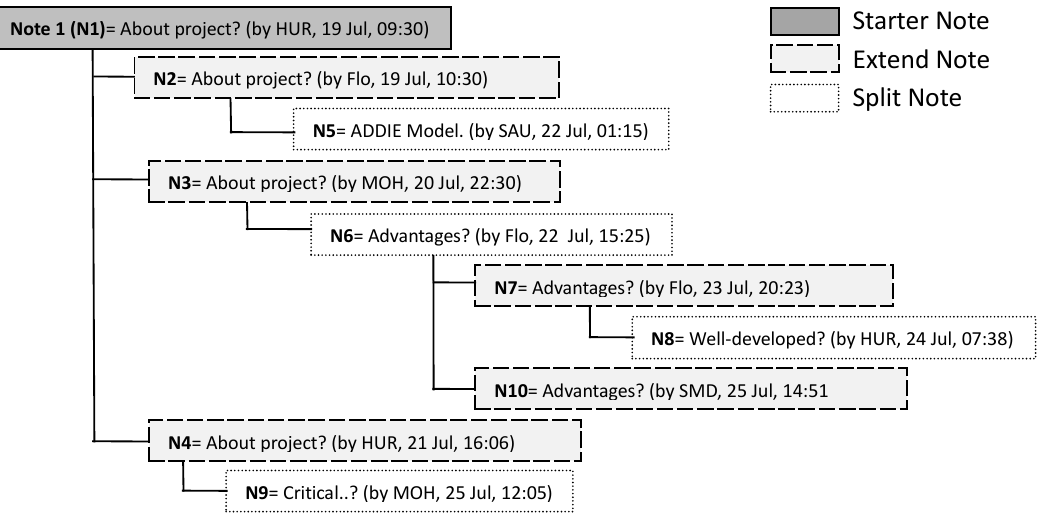
Figure 1 . Example of a thread with different types of notes.